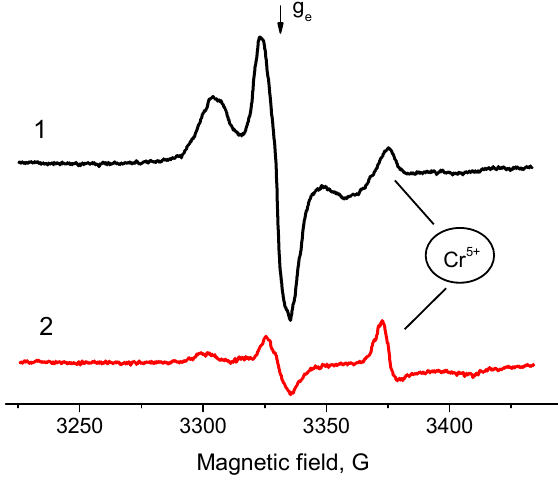
Figure 14. EPR spectra of TNB radical anions adsorbed on ZrO 2 ( 1 ) and sulfated ZrO 2 ( 2 ). T act = 500 °C.